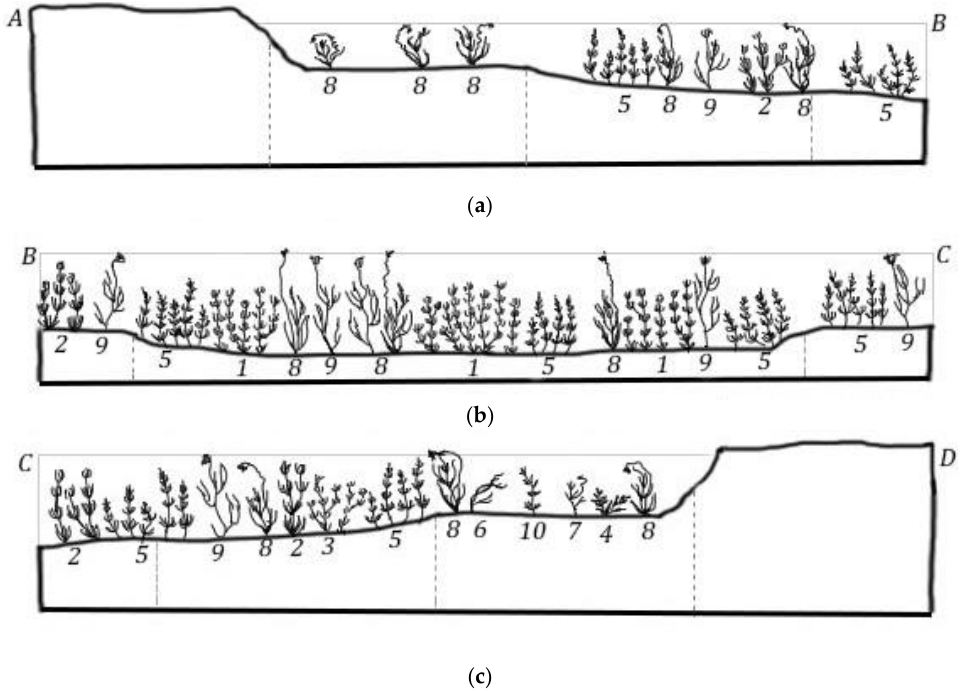
Figure 3. ( a ) A – B: Vegetation transect of the saline riparian zone. ( b ) B – C: Vegetation transect of the Figure 3. ( a ) A–B: Vegetation transect of the saline riparian zone. ( b ) B–C: Vegetation transect of deeper central zone. ( c ) C – D: Transect of vegetation of the riparian zone influenced by the inflow of the deeper central zone. ( c ) C–D: Transect of vegetation of the riparian zone influenced by the in- flow of water from surface runoff, generally freshwater. Species present [24,36,37]: 1 Chara galioides